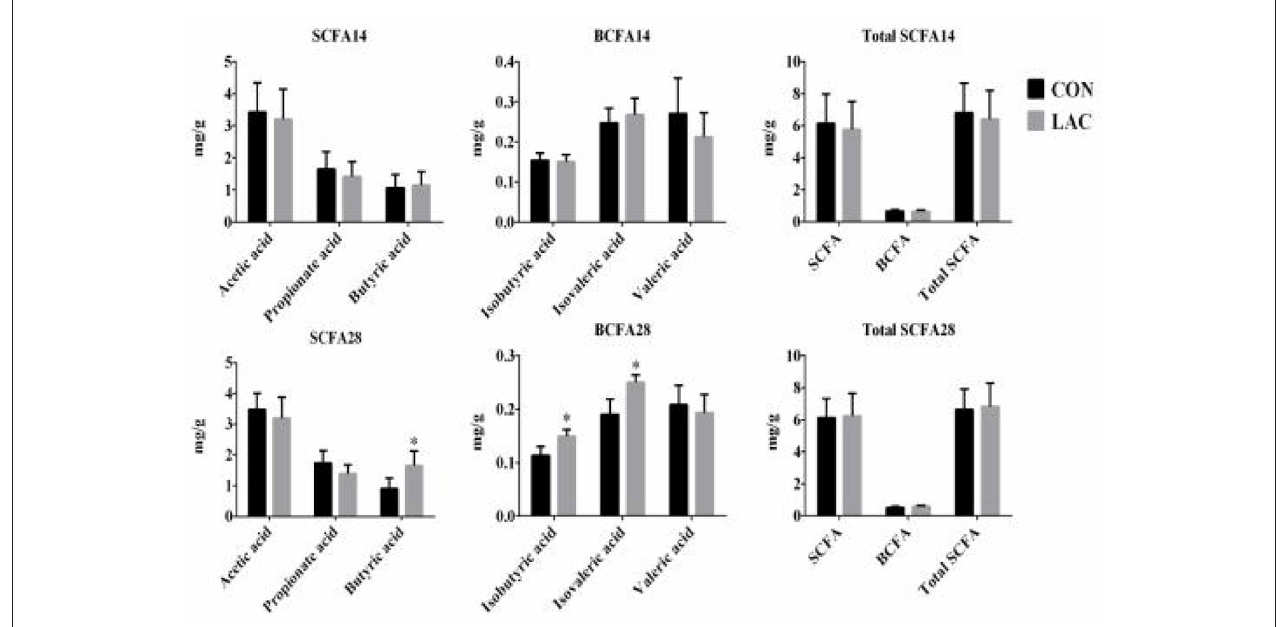
FIGURE 6 | Effects of Lactobacillus delbrueckii on the concentrations of the short-chain fatty acids in the colon digesta of the weaned piglets. CON, basal diet; LAC, basal diet group with 0.1% Lactobacillus delbrueckii ; SCFA, short-chain fatty acid, including acetic acid, propionic acid, and butyric acid BCFA, branched-chain fatty acid, including isobutyric acid, isovaleric acid, and valeric acid. Total SCFA, total short-chain fatty acid, including acetic acid, propionic acid, butyric acid, isobutyric acid, isovaleric acid, and valeric acid. N = 4. Label (*) mean significant difference between the CON group and the LAC group ( p < 0.05); 14 and 28 represent the 14 and 28 days of the trial period,